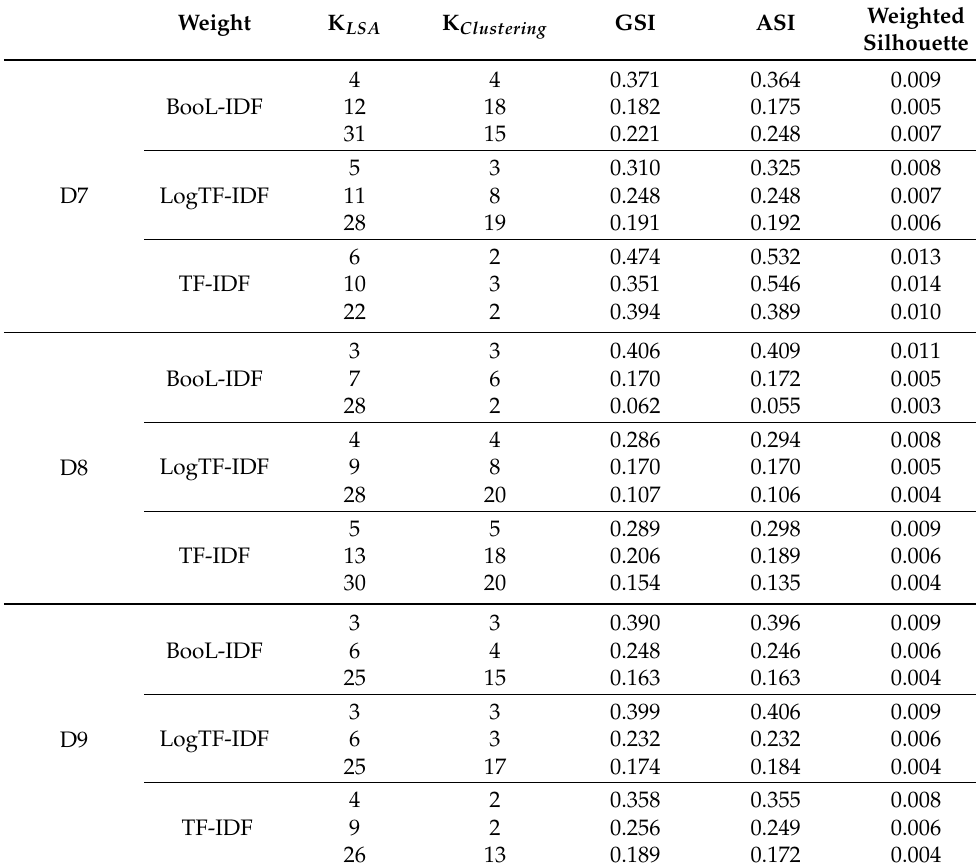
Table 13. Experimental results through the